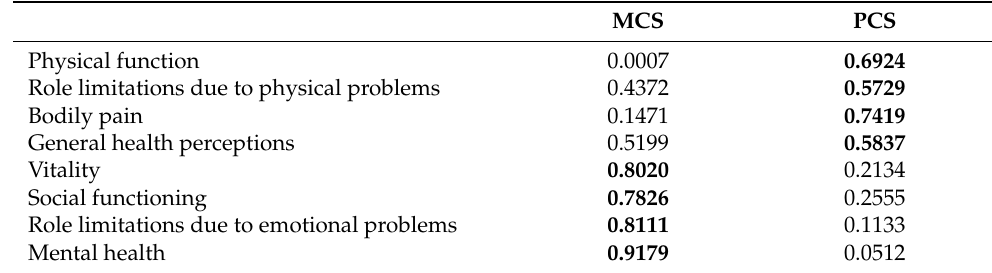
Table A4. Correlation between the summary measures of the SF-36 and each of the eight